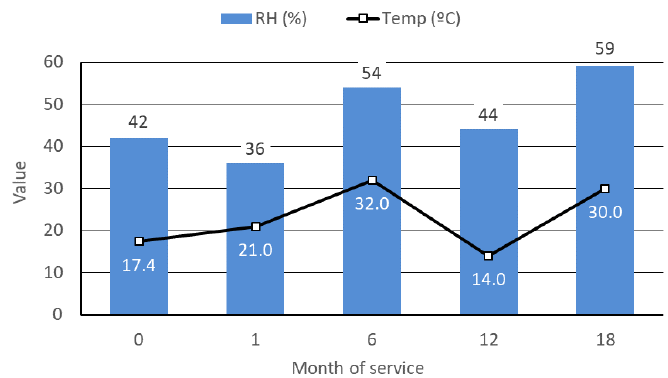
0.300.310.320.330.340.350.360.370.38 X Acceptance Criteria: Inside the Polygon Chromatic Coordinates X,Y of the 18 testing samples over time Figure 6. Chromatic coordinates ( X , Y ) of the 18 testing samples during the 18-month testing period.